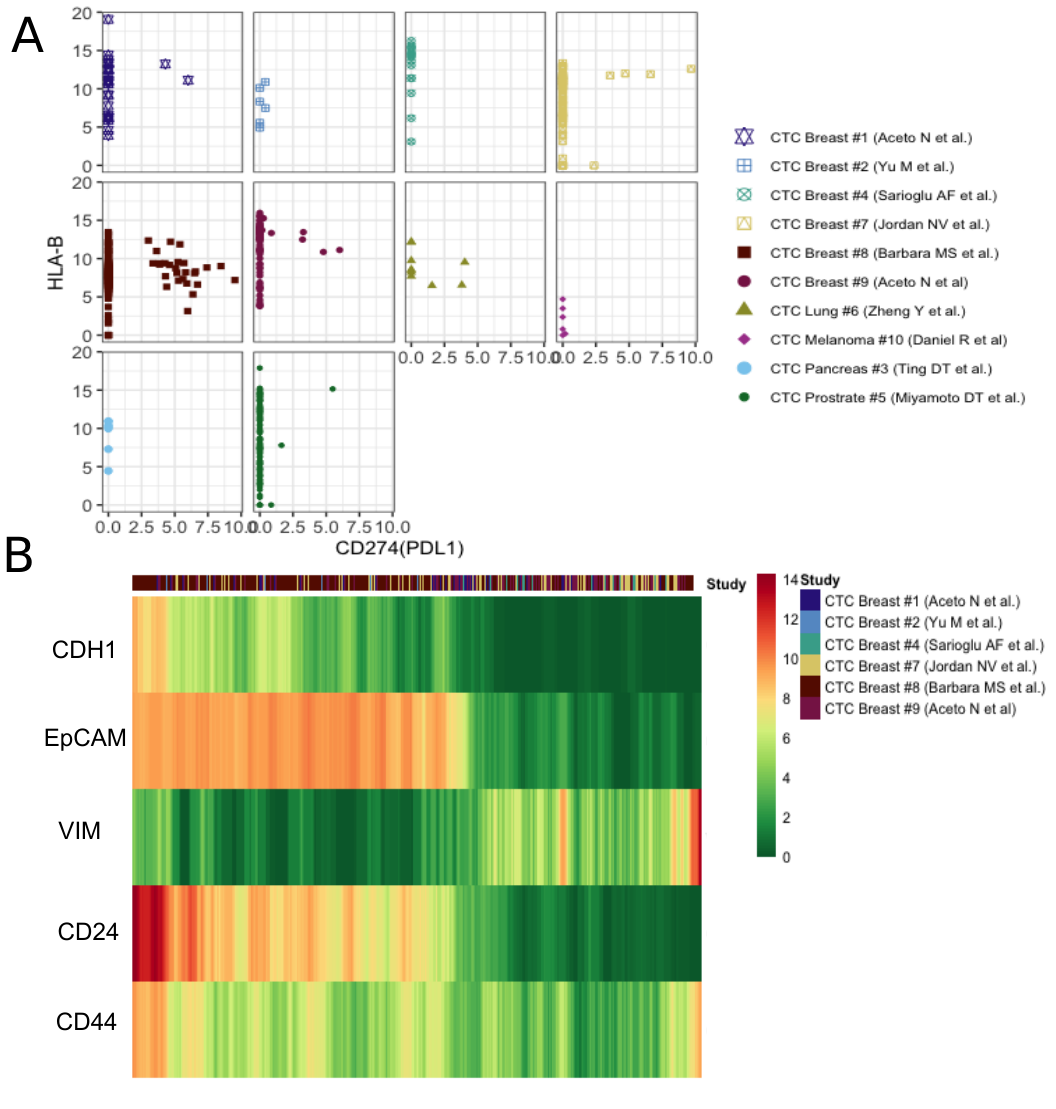
Figure 3. Patterns observed in expression gradient of immune check-point inhibitor and stemness markers. ( A ) The scatter plot of PDL1 and HLA-B expression in each study. ( B ) The moving average smoothen log(expression+1) of well known specific epithelial (CDH1,EpCAM), mesenchymal(VIM) and cancer stem cell markers (CD24, CD44) across breast CTCs,ordered based on the ratio of epithelial and mesenchymal signatures calculated as described in the main